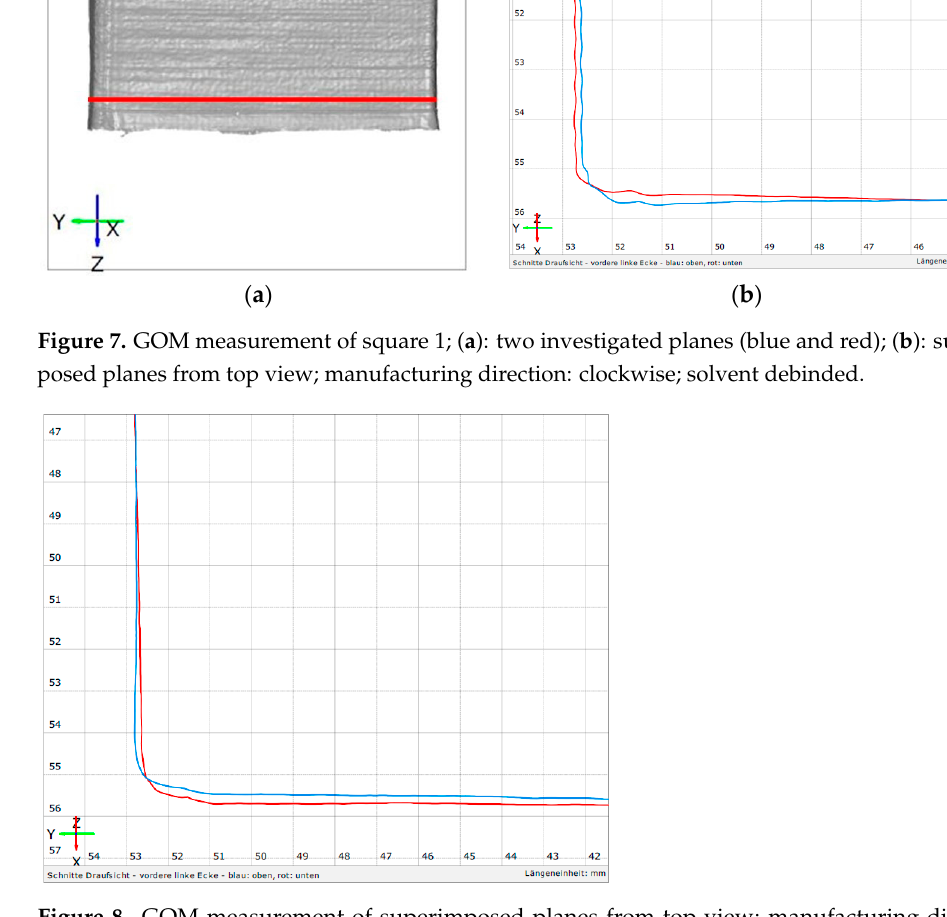
Figure 9. GOM measurement of superimposed planes from top view; manufacturing direction: al- ternating ( n = 2); solvent debinded.